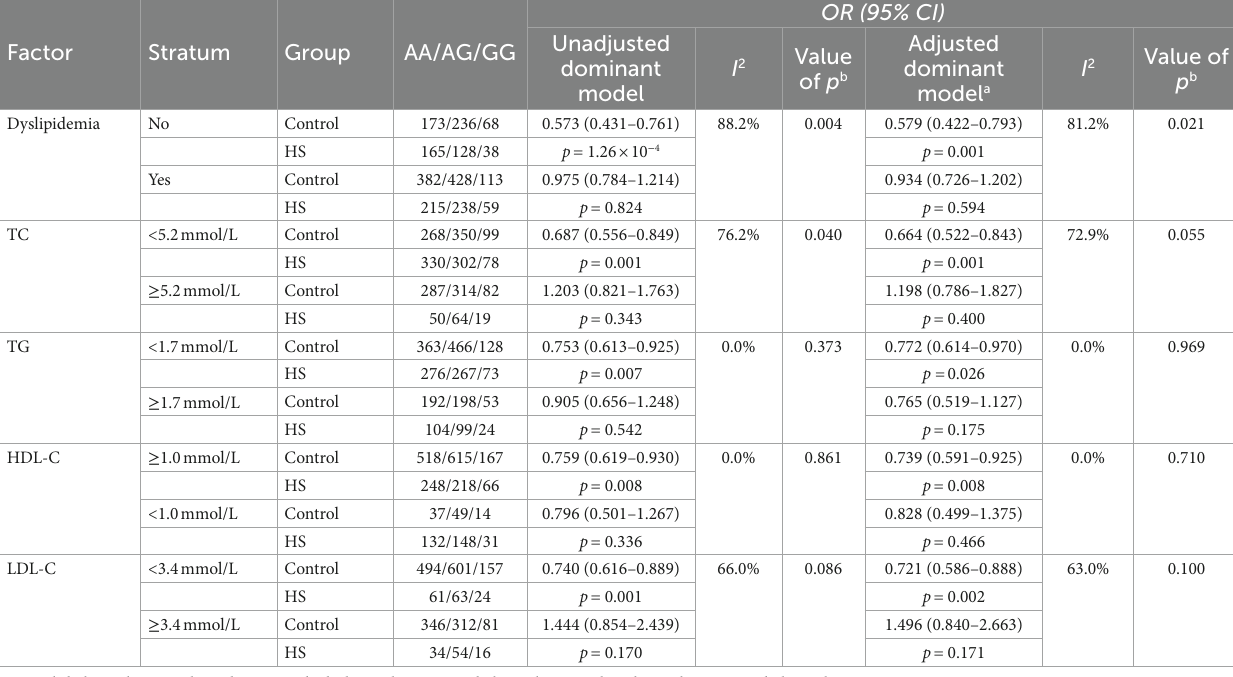
TABLE 3 Stratification analyses of dyslipidemia for the association of rs3803264 and the risk of hemorrhagic stroke in the case–control study.